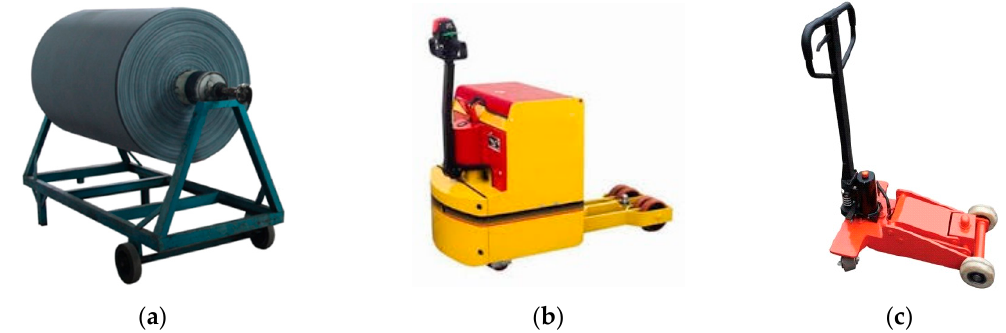
Figure 1. ( a ) Fabric loaded batch trolley, ( b ) Electric Towing Tractor, ( c ) Human-Powered Towing Tractor.